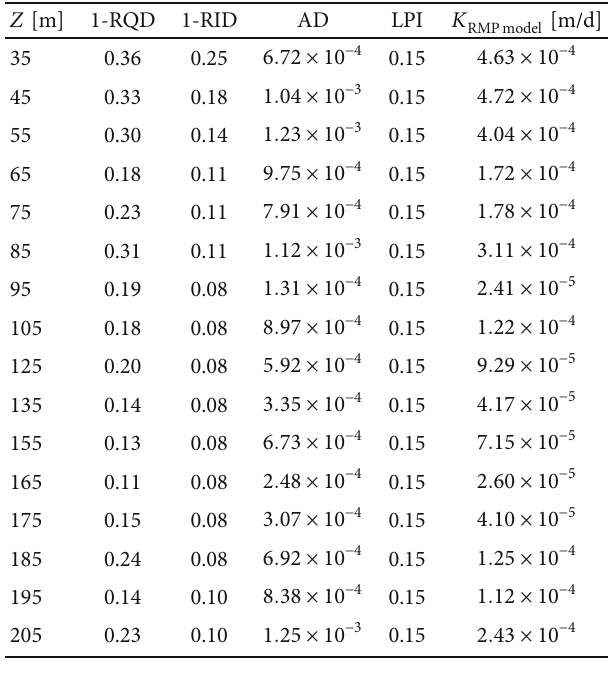
Table 4: RMP model estimation results of ZK76.